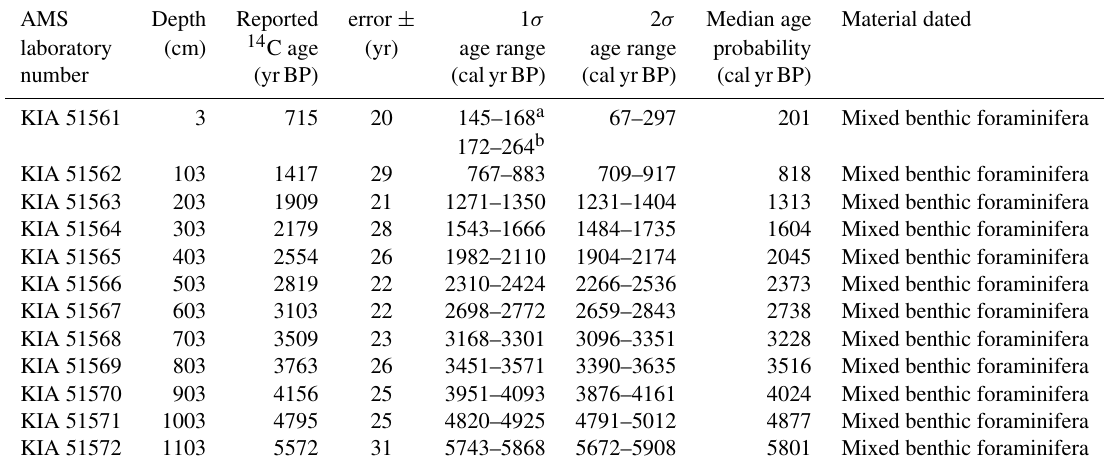
Table 1. Twelve AMS radiocarbon dates, calibrated in Calib7.1 (Stuiver and Reimer, 1993; Stuiver et al., 2017) using the Marine13 dataset (Reimer et al., 2013) with a reservoir correction of (cid:49)R = 144 ± 38 years (McNeely et al., 2006). AMS